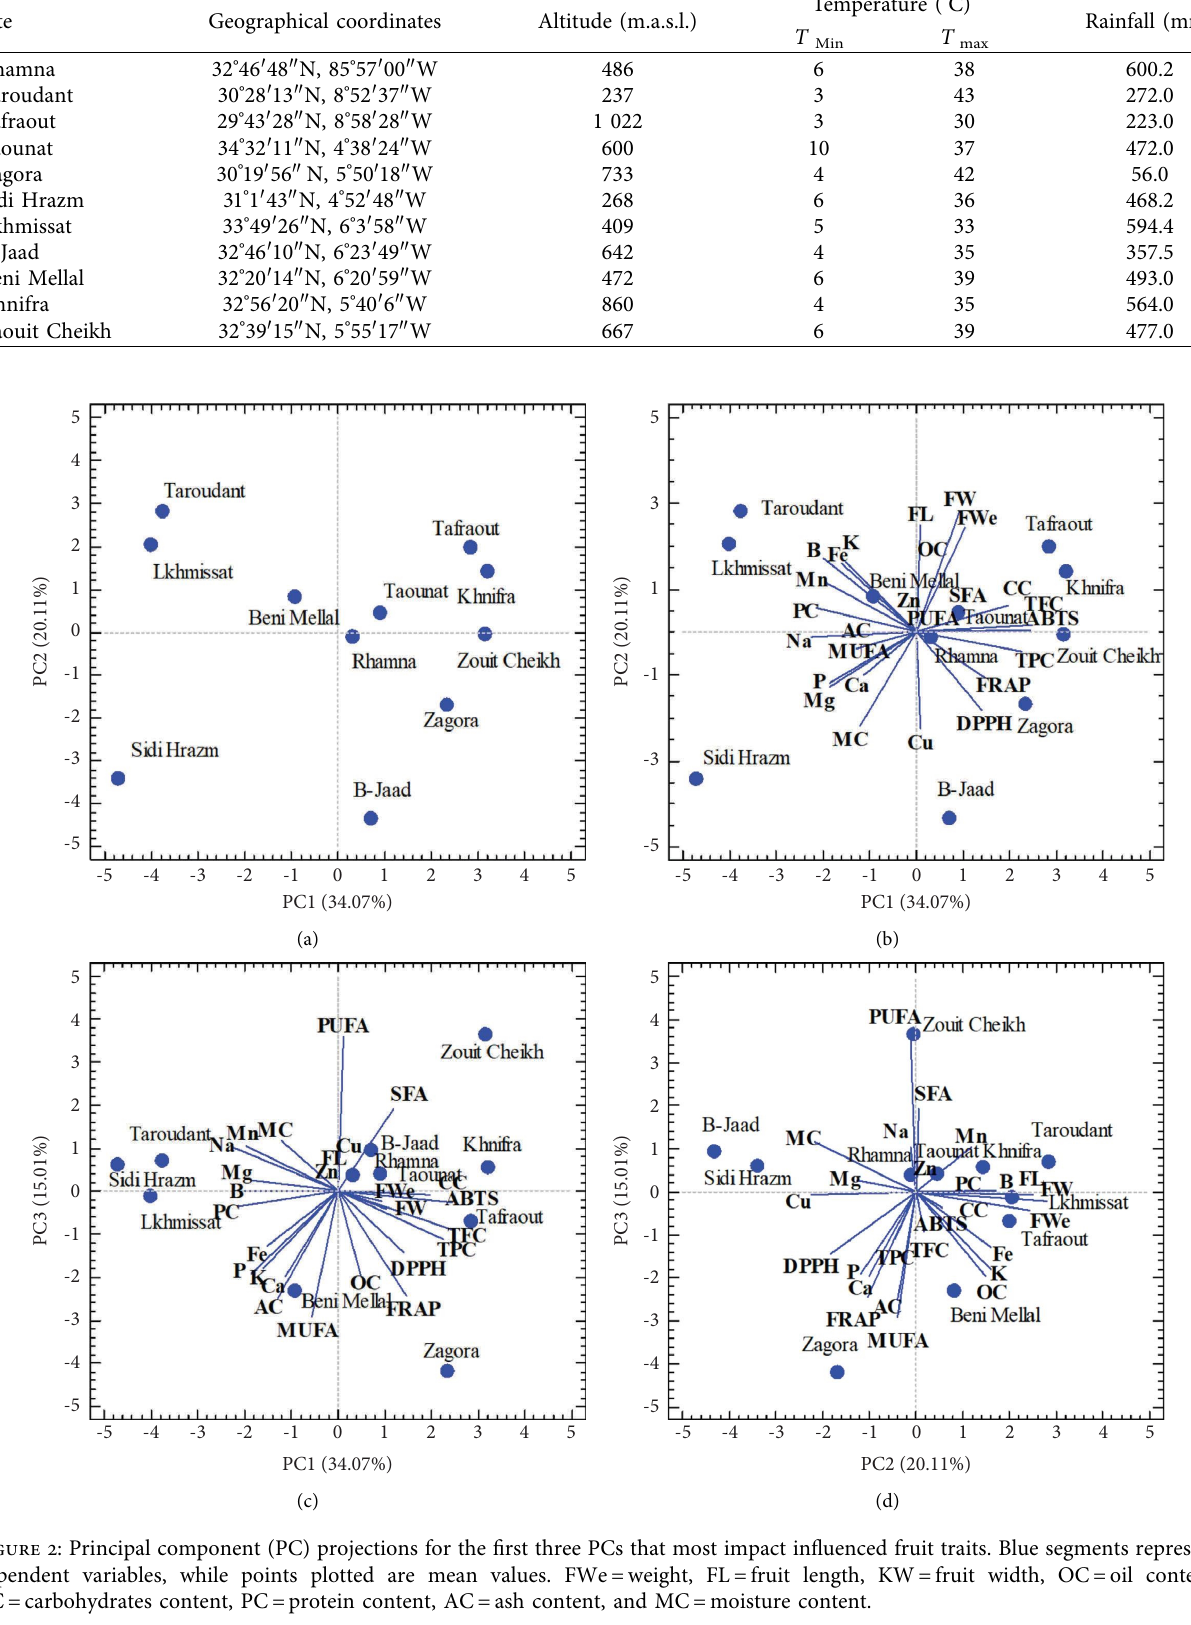
Table 6: Geographical and climatic data for the sampling agro-ecological areas.